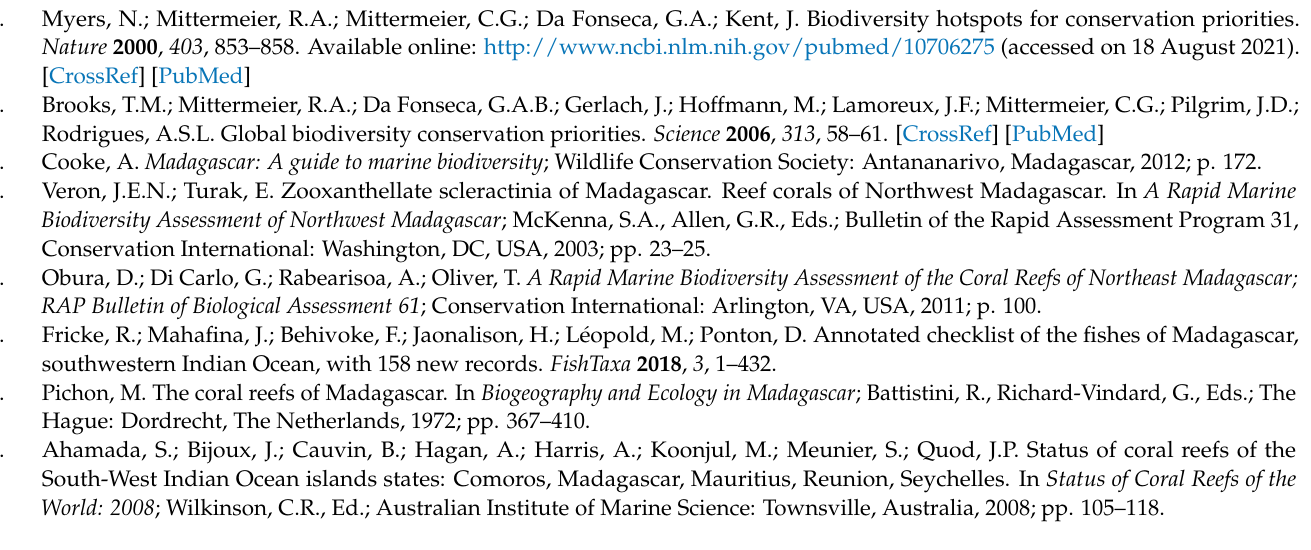
Table S5: Summary of the nested ANOVA to test for spatial variability in generic richness among habitats and stations; Table S6: Summary of the pairwise t -tests to identify differences between habi- tats for generic richness; Table S7: Summary of the pairwise t -tests to identify differences between stations for generic richness; Table S8: Summary of the nested ANOVA to test for spatial variability in overall abundance of coral colonies among habitats and stations; Table S9: Summary of the pairwise t -tests to identify differences between habitats for abundance of coral colonies; Table S10: Sum- mary of the pairwise t -tests to identify differences between stations for abundance of coral colonies; Table S11: Summary of the ANOSIM for pairwise comparison in the composition and abundance of coral genera between habitats; Table S12: Composition and abundance (mean number of colonies per station) of coral assemblages at the 10 stations used for nonmetric multidimensional scaling (nMDS); Table S13: Summary of the ANOVA per permutation for comparison of the size frequency distribution among each habitat based on the colony abundances; Table S14: Summary of the pair- wise t -test of the size frequency distribution between habitats based on the colony abundances; Table S15: Summary of the pairwise test of the size frequency distribution based on the colony abun- dances; Table S16: Coral genera (scleractinians and the calcareous hydrocoral Millepora ) recorded in the Toliara region of southwest Madagascar in 2017 (present study) and in 1961–1970 [12], in the Andavadoaka region [19], in the northwest region by Veron and Turak [4], and in the northeast region by Obura et al.